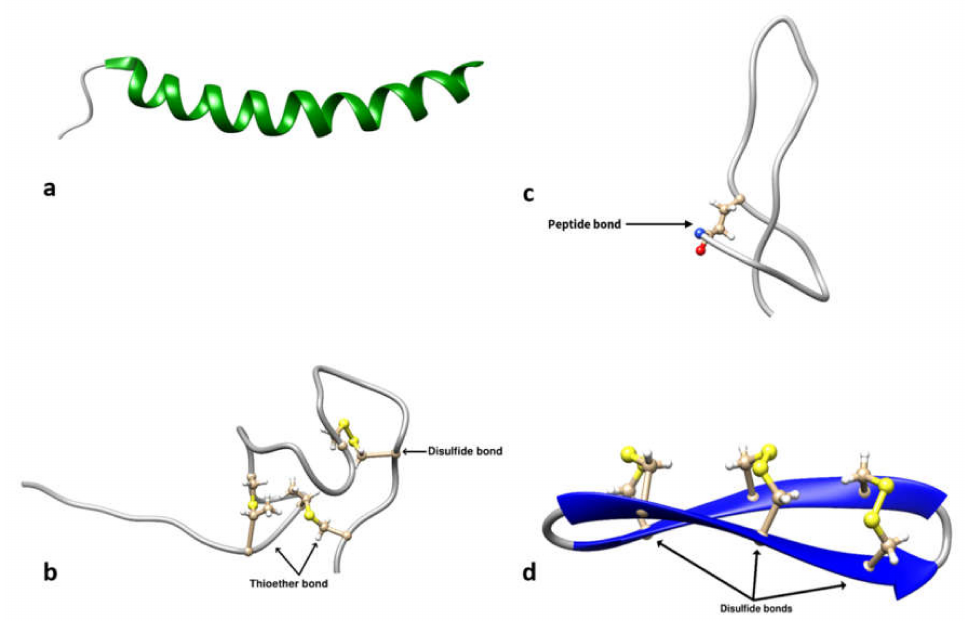
Figure 2. ( a ) UCLL (LL-37, amino acid sequence LLGDFFRKSKEKIGKEFKRIVQRIKDFLRNLVPRTES, PDB entry: 2K6O). ( b ) UCSS (bovicin HJ50, amino acid sequence ADRGWIKTLTKDCPNVISSICAGTIITACKNCA, PDB entry: 2M8V). ( c ) UCSB (microcin J25, amino acid sequence GGAGHVPEYFVGIGTPISFYG, PDB entry: 1Q71). ( d ) UCBB (rhesus theta defensin-1, amino acid sequence GFCRCLCRRGVCRCICTR, PDB entry: 2LYF). Specifically, dilsufide and thioether bonds in ( b , d ) are represented by ball-and-stick model, with sulfur, carbon, and hydrogen atoms indicated in yellow, beige, and white, respectively; peptide bond in ( c ) is represented by ball-and-stick, with nitrogen, oxygen, carbon, and hydrogen atoms indicated in blue, red, beige, and white,